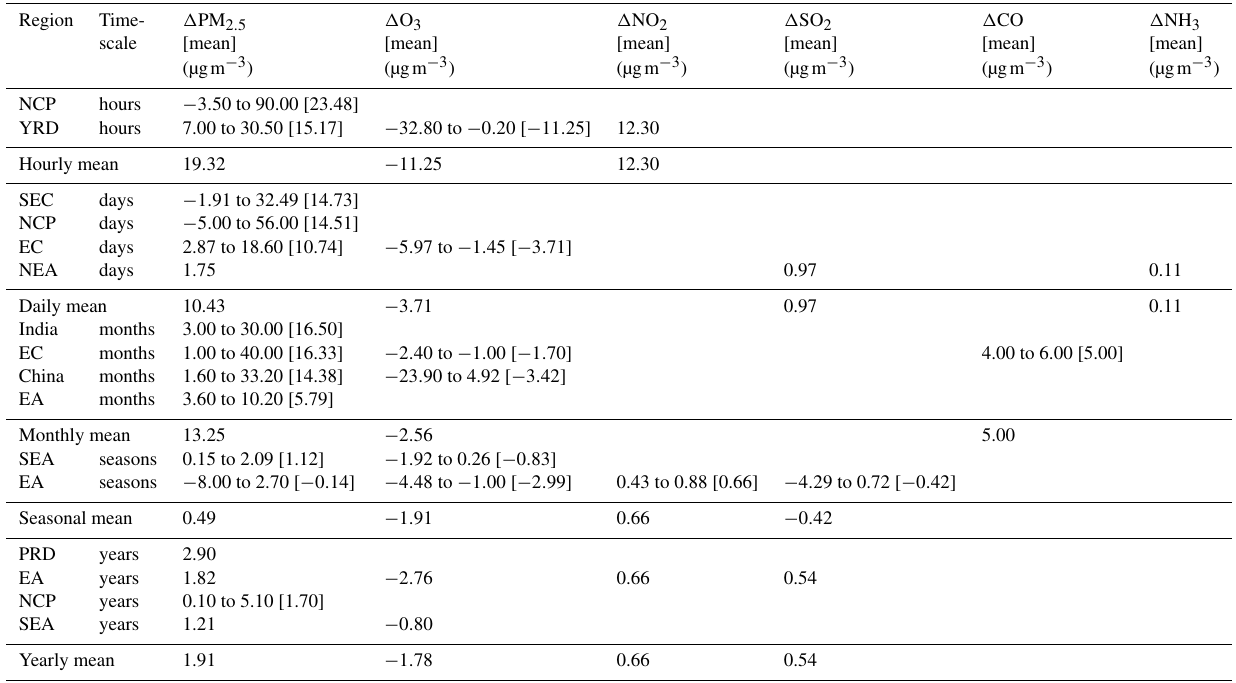
Table 8. Compilation of aerosol-induced variations of PM 2 . 5 and gaseous pollutants simulated by two-way coupled models (WRF-Chem, WRF-CMAQ, GRAPES-CUACE, WRF-NAQPMS, and GATOR-GCMOM) in different regions of Asia and at different temporal scales.